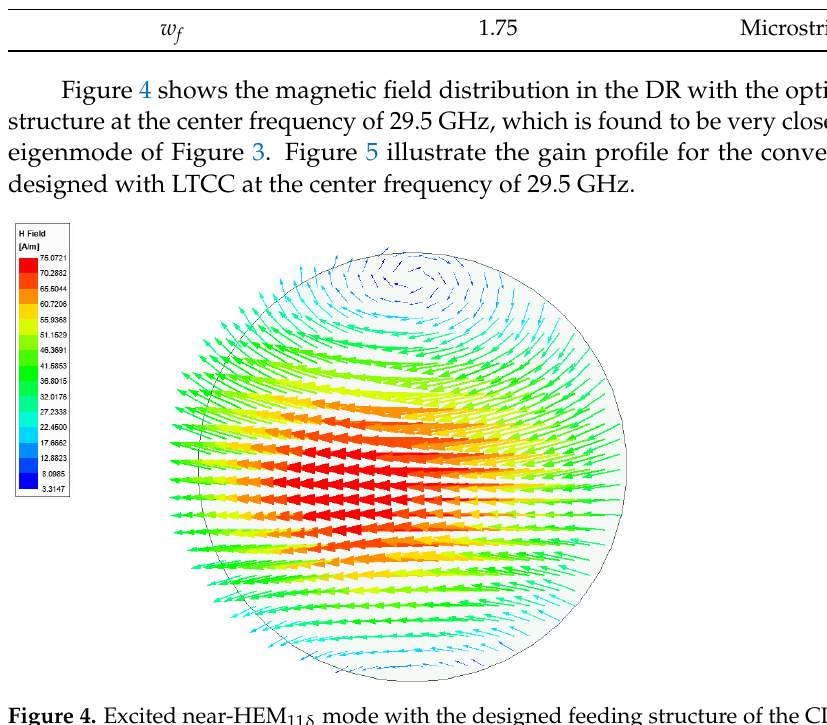
Figure 5. Simulated gain profile for the conventional CDRA design in LTCC at 29.5 GHz. 2.2. New CDRA Design with a Grooved Superstrate In the conventional CDRA design, the placement of the DR on top of the ground plane, where the radiation slot is located, is done manually, which leads to alignment pre- cision issues that can easily impact the antenna gain and/or bandwidth. This issue can be compounded in an array setting. To tackle this issue, we propose a new LTCC stack, which consists of the stack of the conventional design on top of which a grooved superstrate, i.e., an additional LTCC layer with a hole, is added as shown in Figure 6. The groove is a precision laser milled during the LTCC fabrication process to generate a groove which is the exact size of the DR, within a 5 µm tolerance.